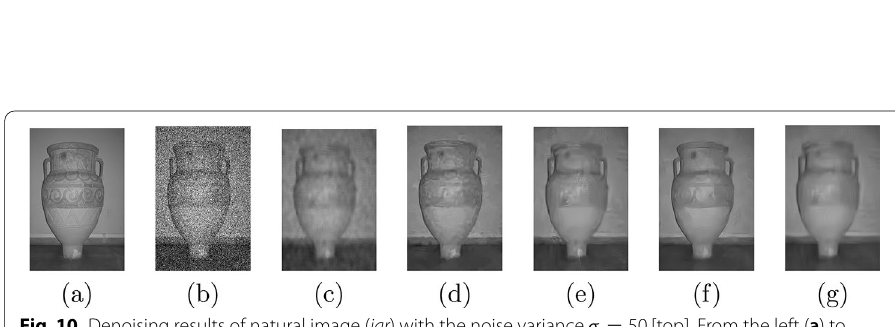
Fig. 10 Denoising results of natural image ( jar ) with the noise variance σ = 50 [top]. From the left ( a ) to right ( g ) are: the original image, the noisy image, the results obtained by NLM, BM3D, OGLR, ADnet and the proposed method